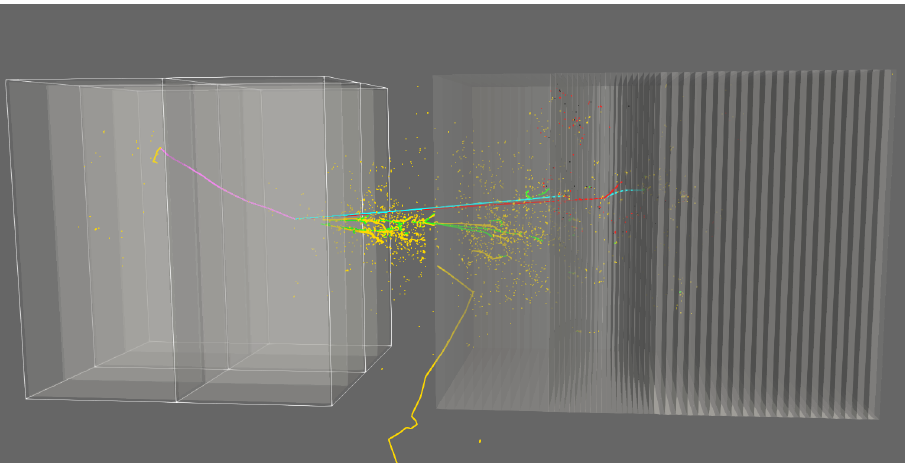
Figure 32. Example simulated event for a 7GeV ν µ –argon CC interaction, in which particles not contained in the ArgonCube 2 2 exit downstream, and are seen in the repurposed MINERvA × detector components. Energy deposits are color-coded according to the particle type: π ± —blue; µ ± —purple; e + —green; e − —yellow; proton—red; recoiling nuclei—black. The event vertex was randomly placed inside the active volume of the 2 2 Demonstrator ×